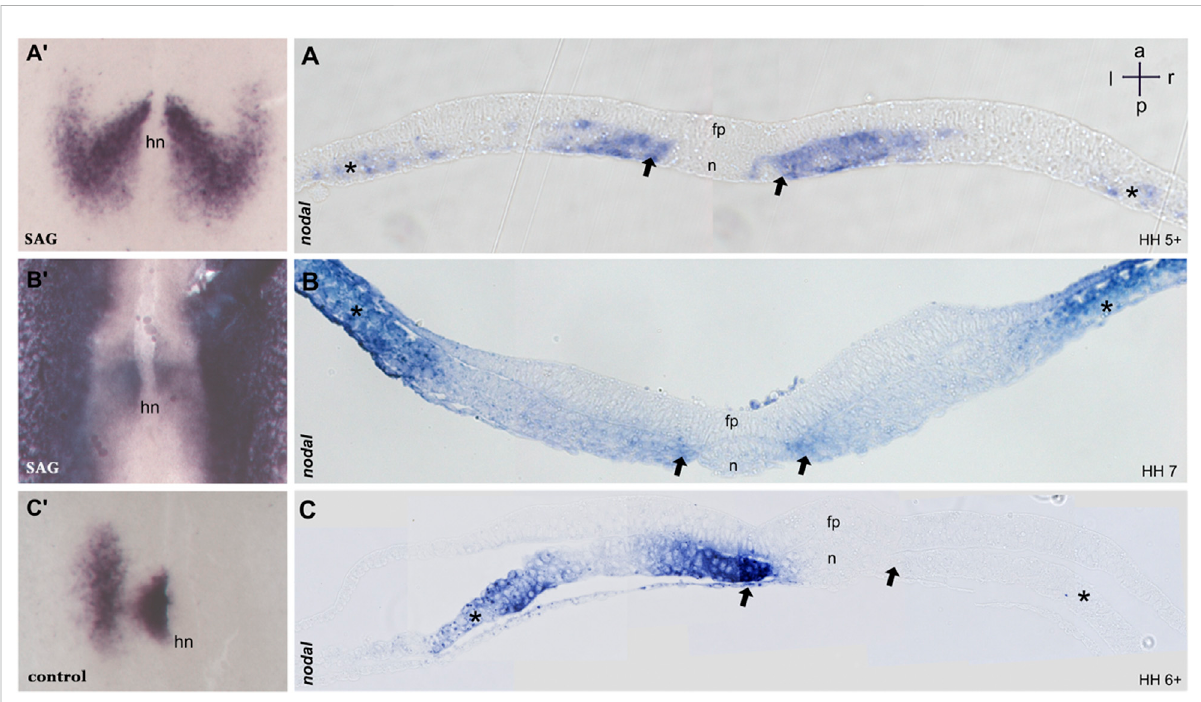
FIGURE 2 SectionsofembryostreatedwithSAG. (A – C) 5 μ mtransversalsectionsofplastic(Technovit)embeddedembryosatthelevelindicatedin A 9 – C 9 , respectively. At stage 5, nodal expression is con fi ned to the paraxial mesoderm and to mesodermal cells located laterally (A,A 9 ) . Stage 6 reveals four distinctdomainscon fi nedtotheparaxialmesodermandlateralplatemesodermonbothsides (B,B 9 ) .Controlembryosatstage6revealexpressionin the left paraxial and lateral plate mesoderm (C,C 9 ) . n, notochord; fp, fl oor plate; hn, Hensen ’ s node; asterisk, lateral plate mesoderm; arrow, paraxial mesoderm. Intersecting arrows indicate anatomical